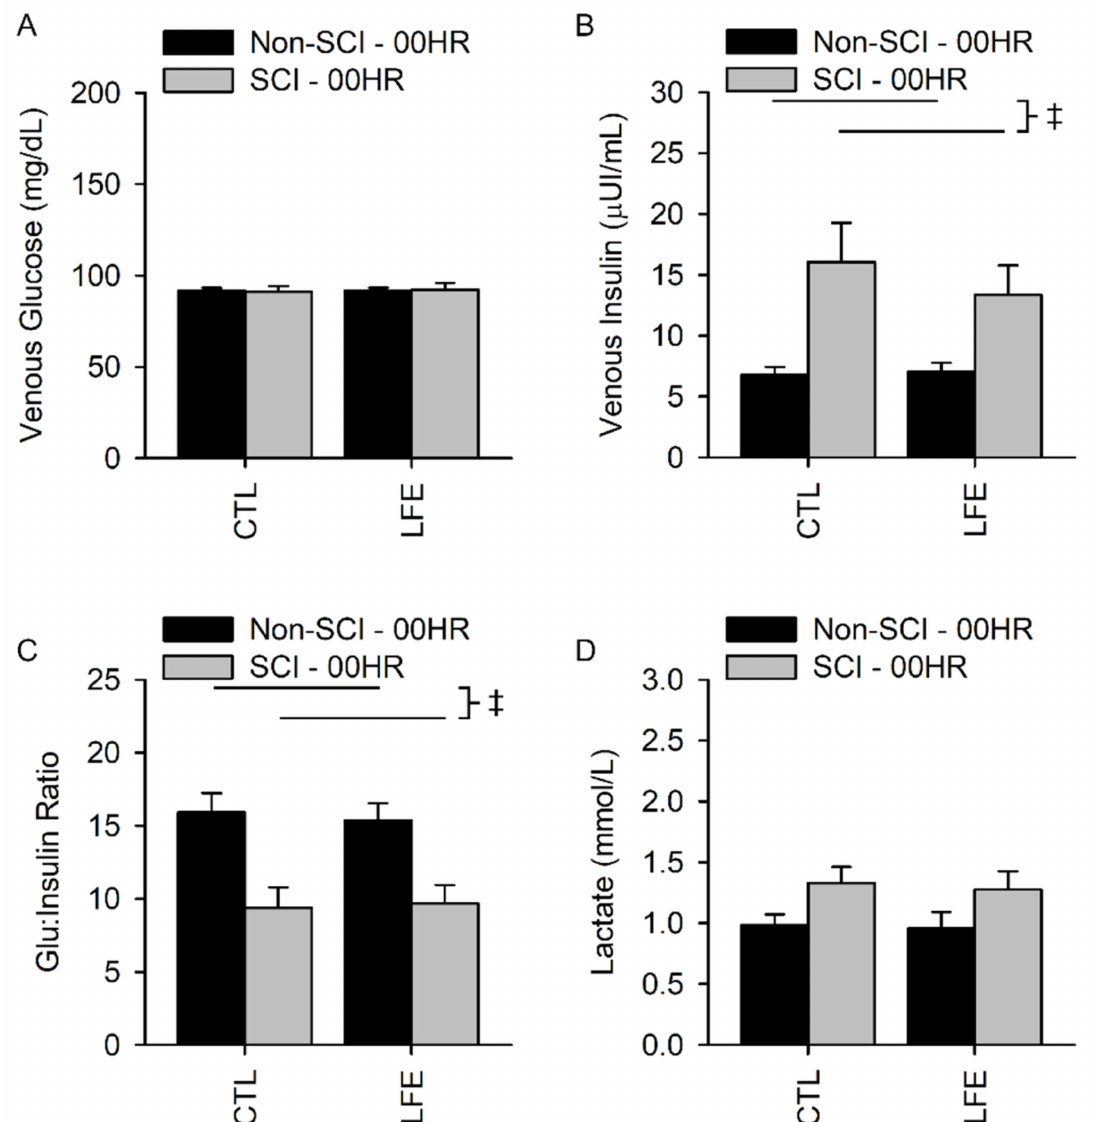
Figure 2. Fasting baseline venous blood biomarkers. There was no difference for fasting serum glucose ( A ) or Lactate ( D ) between people with and without SCI and during the CTL or LFE sessions; but there was a significant difference between insulin ( B ) and the glucose to Insulin ratio ( C ) between SCI and non-SCI. ‡ Indicates a significant difference ( p ≤ 0.05) of the indicated main effect and no significant interaction between session and